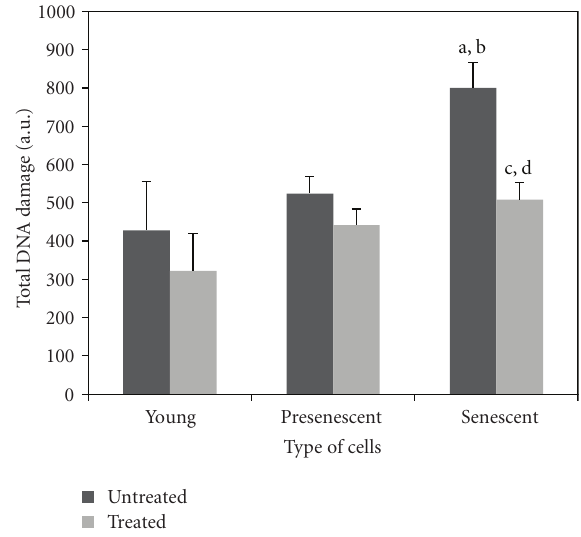
Figure 5: Comparison of total DNA damage at various stages of cellular ageing measured by Comet assay. Damaged DNA was higher in senescent HDFs which was decreased with TRF treatment. a Denotes P < . 05 compared to untreated young HDFs, b P < . 05 compared to untreated presenescent HDFs, c P < . 05 compared to untreated senescent HDFs, d P < . 05 compared to TRF-treated young HDFs. Data are presented as mean ± SD, n =